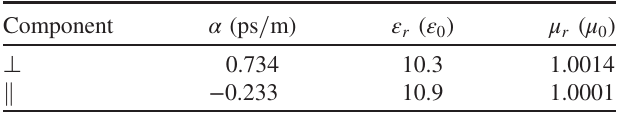
TABLE I. Experimental values of α , relative permittivity ε r , and relative permeability μ r for Cr 2 O 3 , from Refs. [16 – 18]. ε r is measured at room temperature, whereas μ r and α are the low temperature (4 K) values. α has units of inverse velocity in the SI units that we use here.